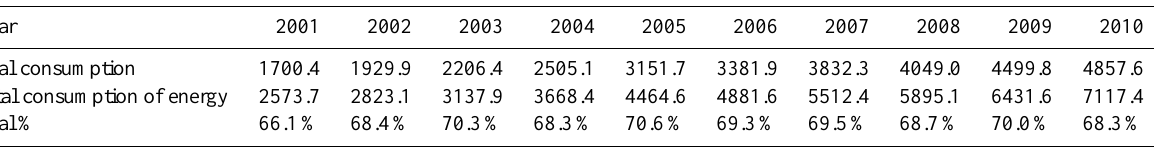
Table 3. The consumption of total energy and coal (10000 tons of Standard Coal Equivalent) and the percentage of coal consumption to total energy consumption from 2001 to 2010 in Chongqing.